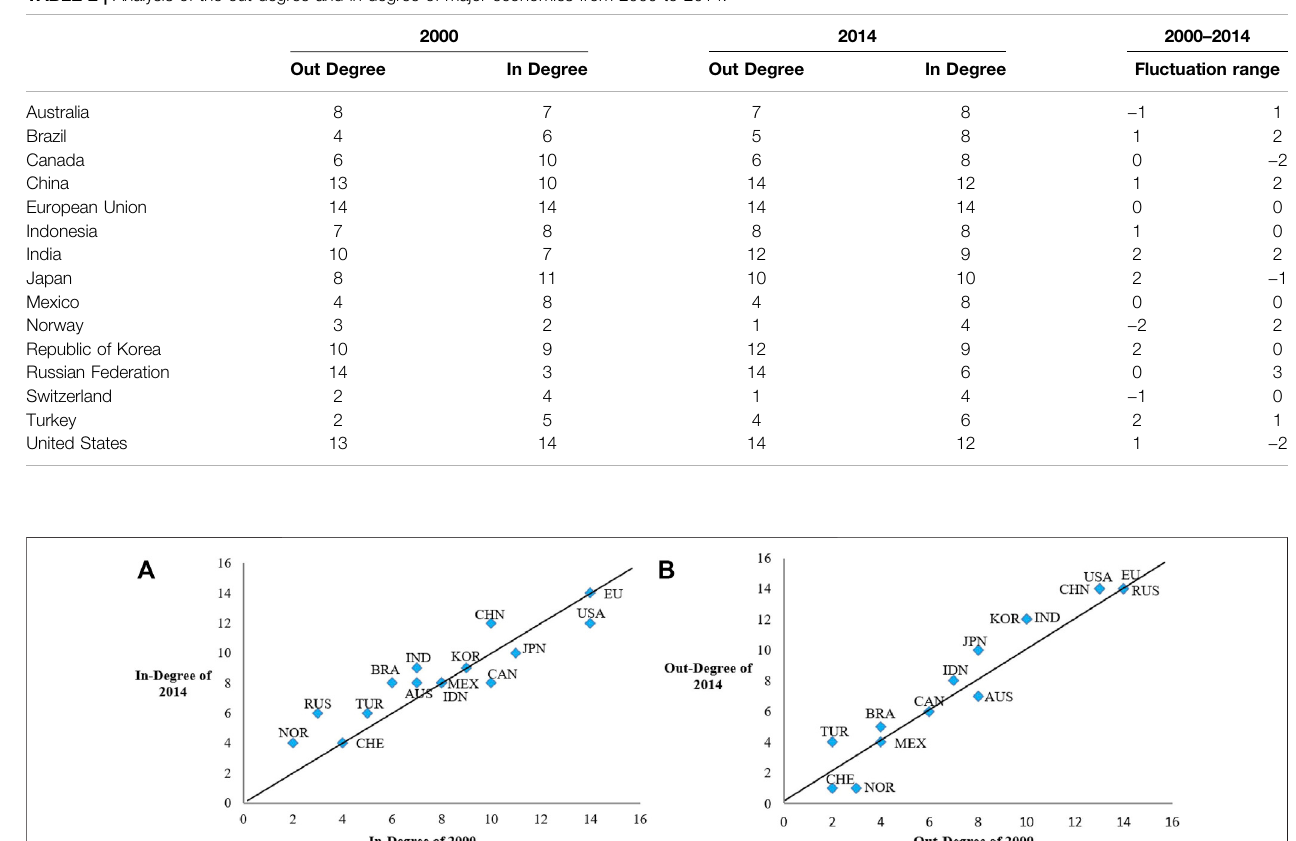
TABLE 2 | Analysis of the out degree and in degree of major economies from 2000 to 2014.